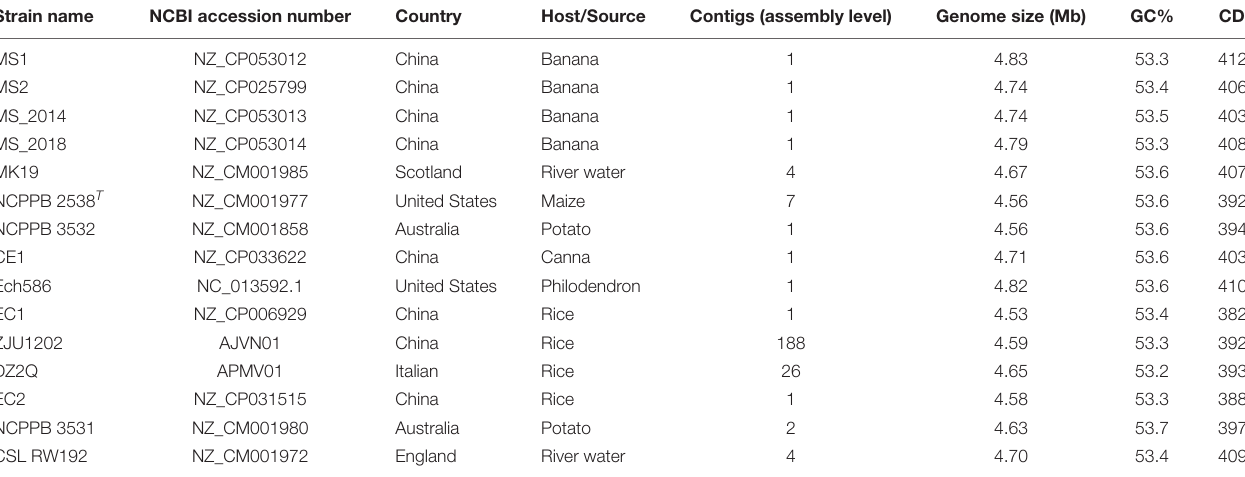
TABLE 1 | Genomes of Dickeya zeae strains used for phylogenetic analysis and genomic